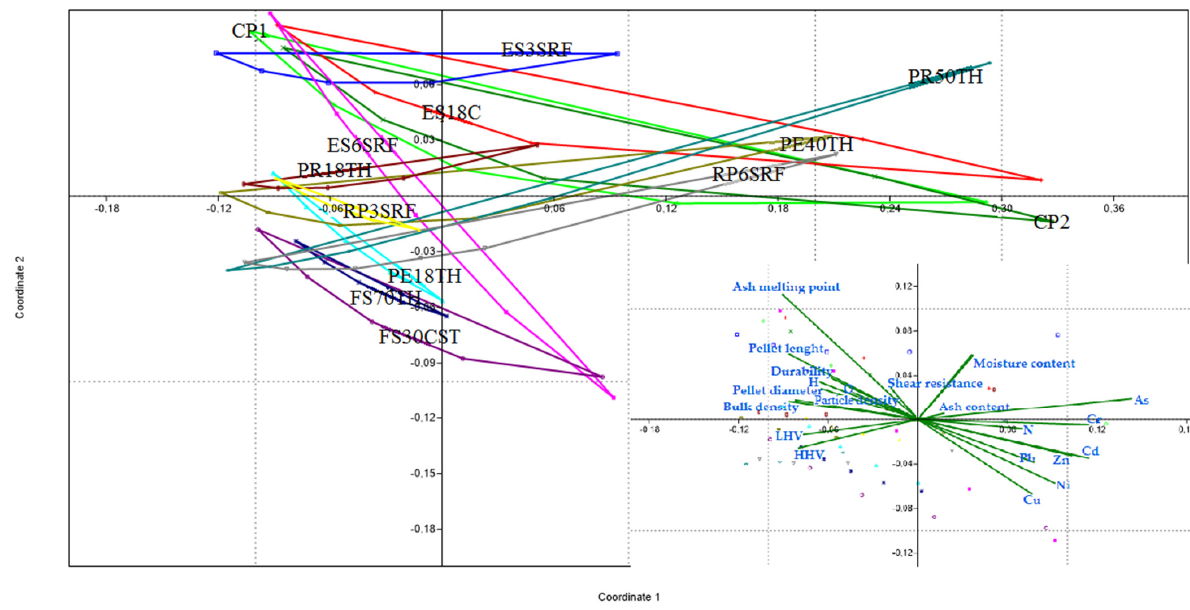
Figure 1. nMDS analysis of main pellet characteristics in terms of possible differences among thirteen pellet types studied (light green: CP1; dark green: CP2; red: ES18C; blue: ES3SRF; violet: ES6SRF; dark violet: FS30CST; dark blue: FS70TH; light blue: PE18TH; olive green: PE40TH; dark red: PR18TH; teal: PR50TH; yellow: RP3SRF; light grey: RP6SRF). The diagram in the right corner shows the detail of the biplot analysis for the relationship among studied coordinates and characteristics.